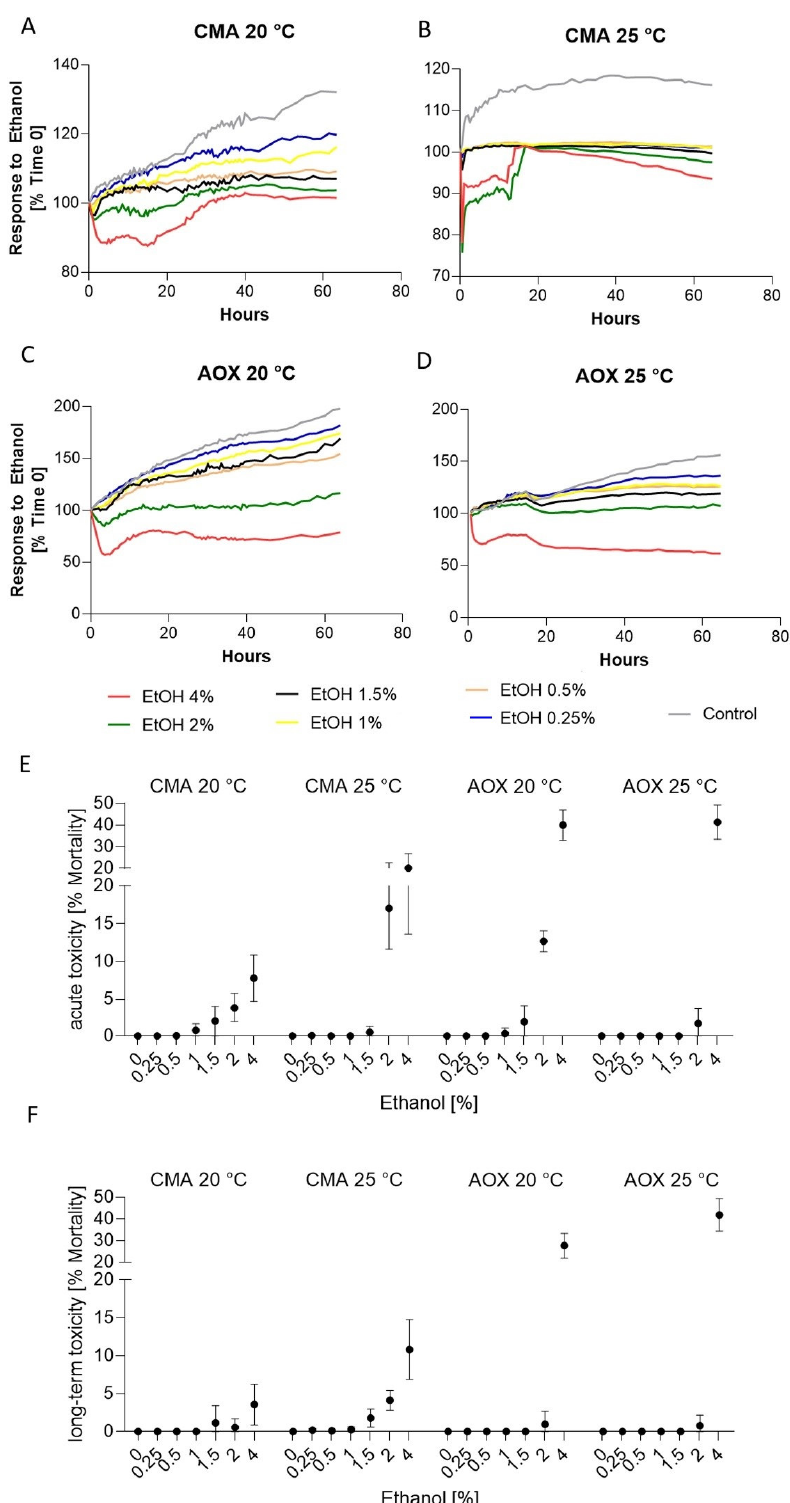
Figure 3. Response of CMAfin1 ( C. maraena ) and AOXlar7y ( A. oxyrinchus ) cells on ethanol addition under 20 and 25 ◦ C cultivation. ( A – D ) Visualization of growth curves over time (% confluence) at different ethanol concentrations (4%—red, 2%—green, 1.5%—black, 1%—yellow, 0.5%—beige, 0.25%—blue, control; 0%—grey). ( E ) Calculated acute toxicity (% mortality compared to the initial confluence value) and ( F ) long-term toxicity (% mortality compared to the initial confluence value) from 4 replicates per experimental